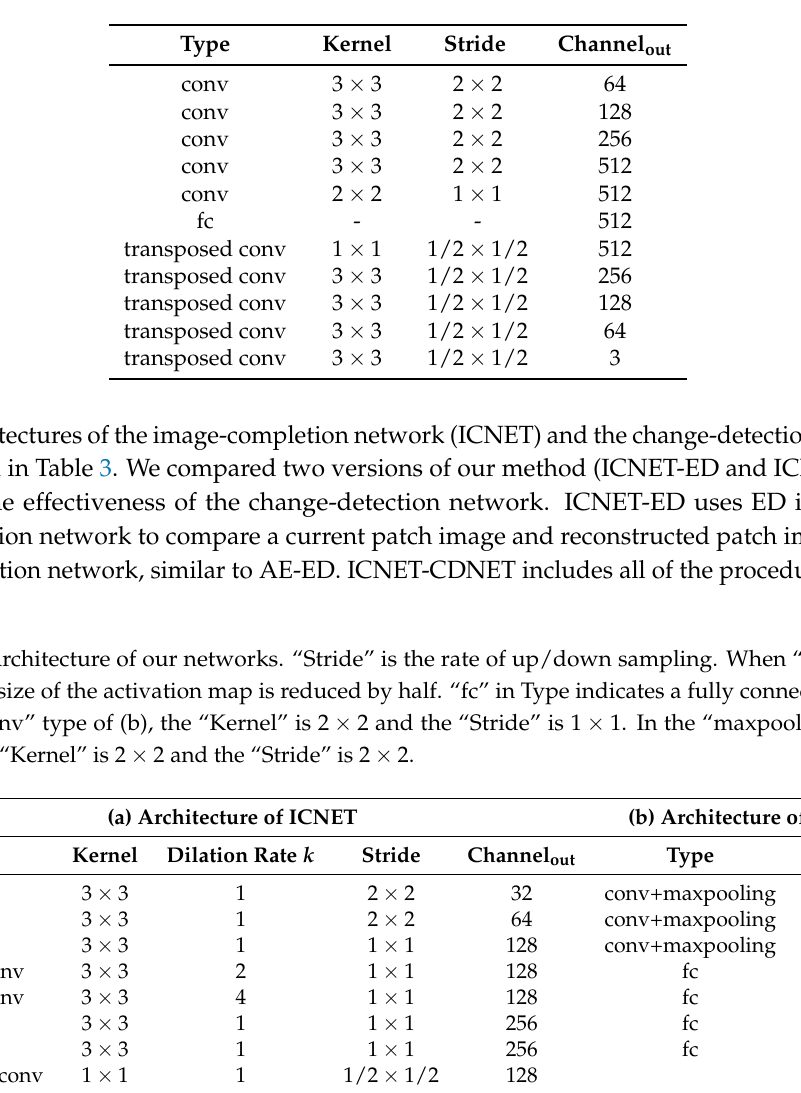
Table 2. Architecture of the autoencoder. “Stride” is the rate of up/down sampling. When “Stride” is 2 × 2, the size of the activation map is reduced by half. “fc” in Type indicates a fully connected layer.